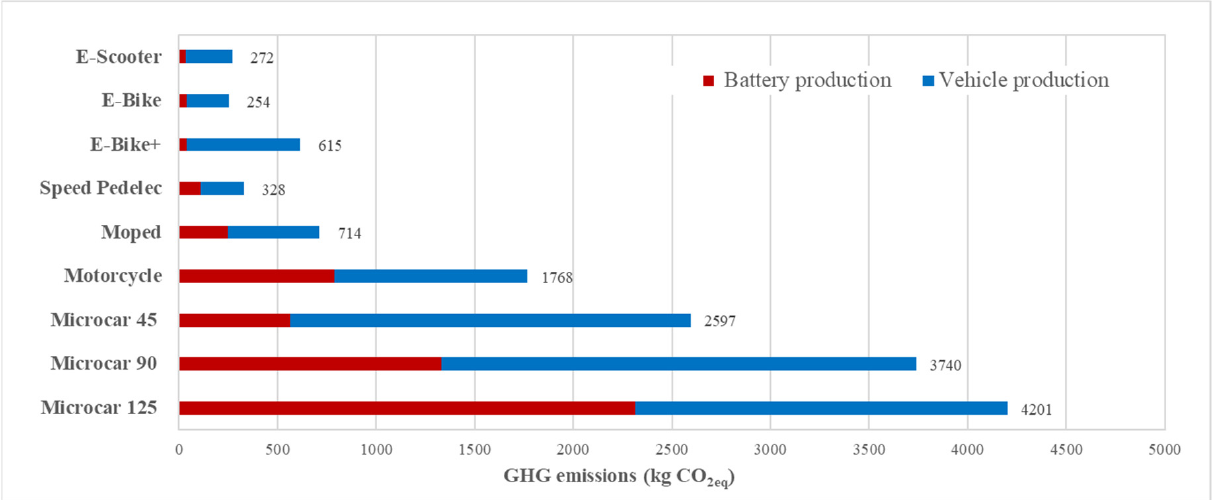
Figure 3. LEV production emission for baseline scenario. mileages of the vehicles are highly relevant, as they reflect the different technical charac- teristics, as well as the different utilities, of the vehicle types. Due to the higher lifetime mileages of the microcar 90 km/h and microcar 125 km/h, the greenhouse gas emissions on a per km basis are closer to the smaller LEVs, which have a lower lifetime mileage (Figure 4).